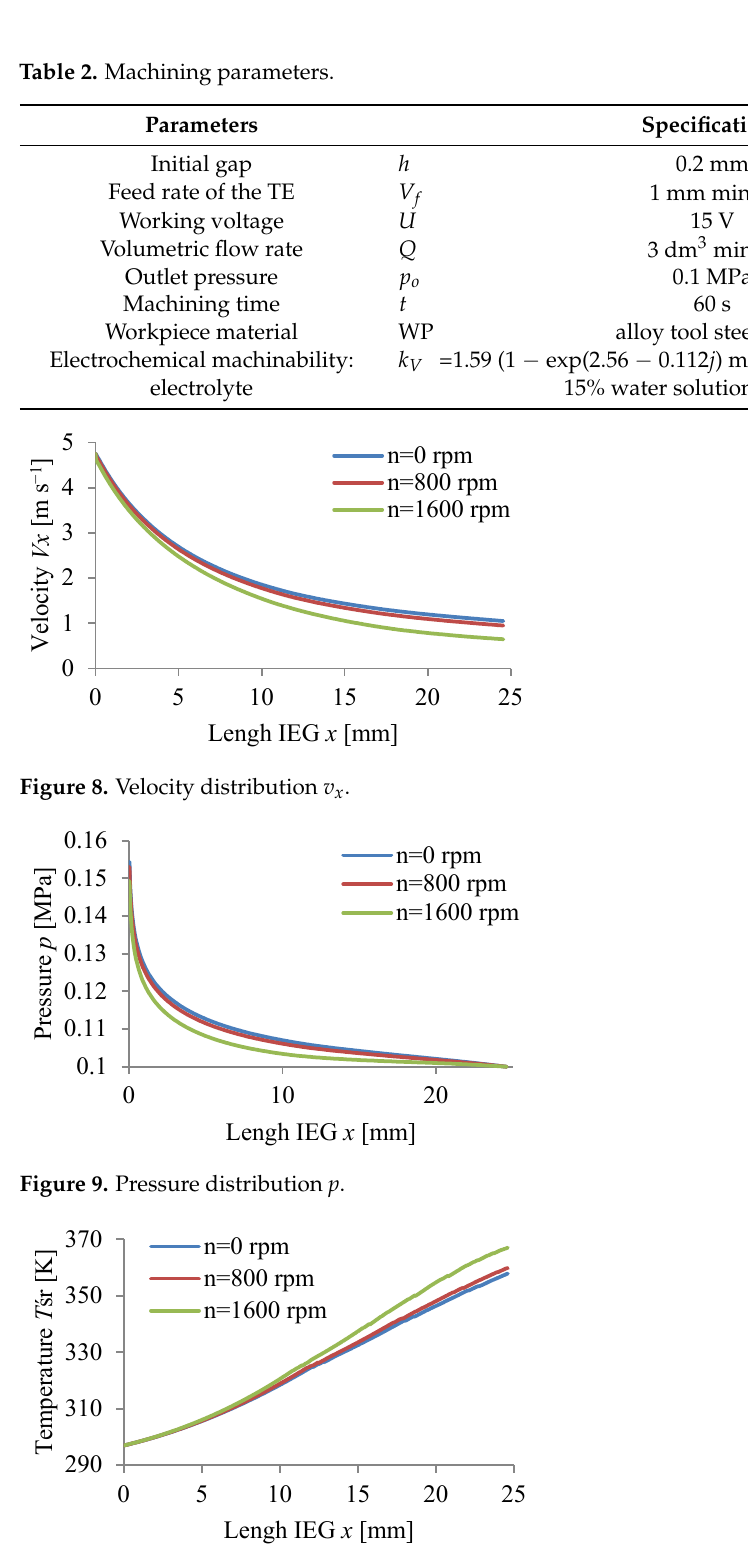
Figure 10. Temperature distribution 𝑇 .